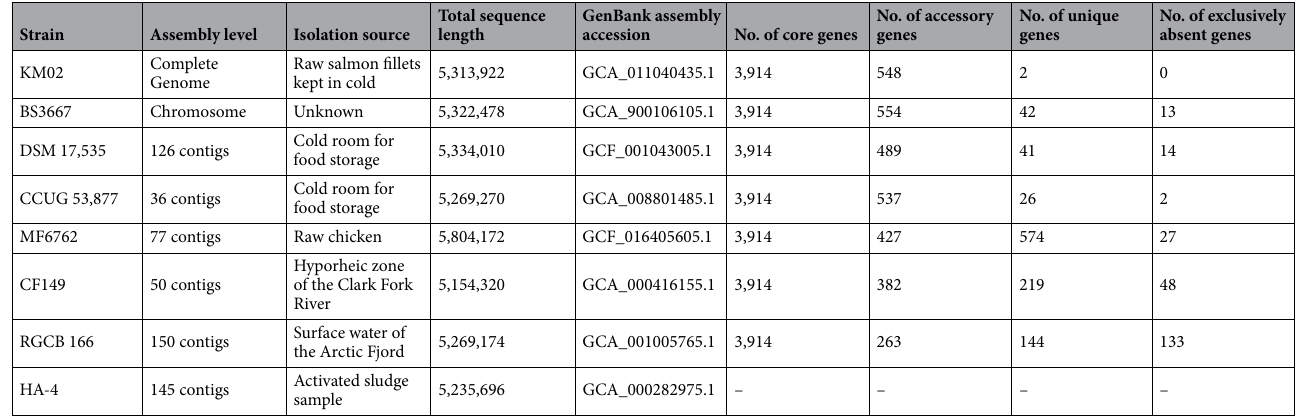
Table 1. P. psychrophila pangenome characteristics.